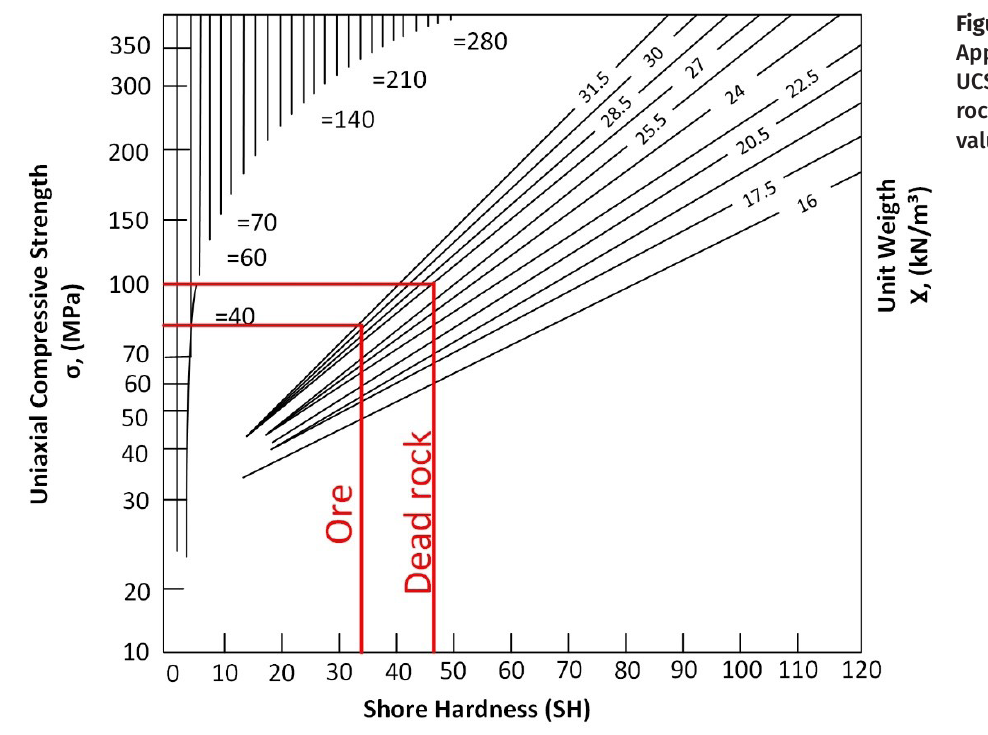
Figure 5. Approximation of UCS of ore and dead rock according to SH